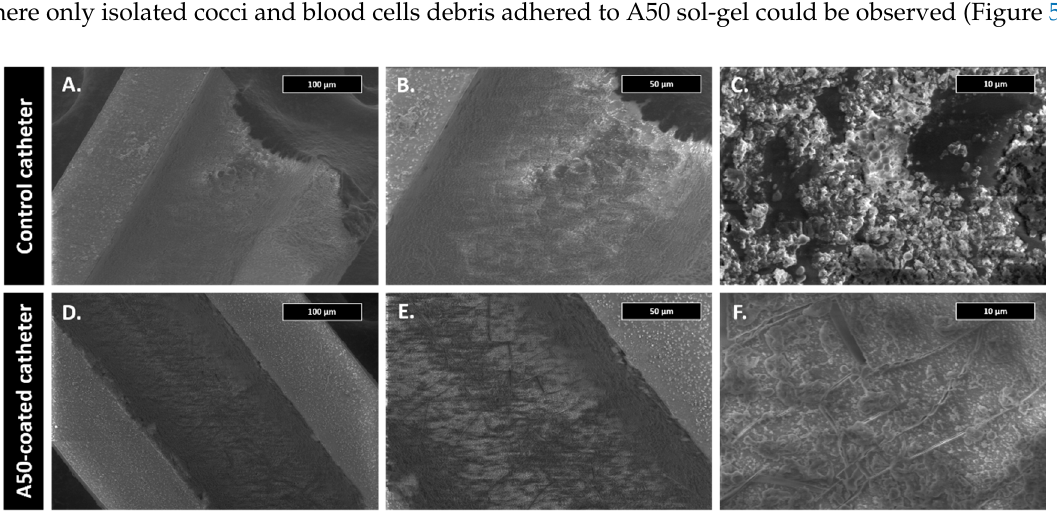
Figure 5. Scanning electron microscopy micrographs of each type of catheter after 21 days in the marginal ear vein from the infection model at 300 × ( A , D ), 600 × ( B , E ), and 5000 × magnifications ( C , F ).